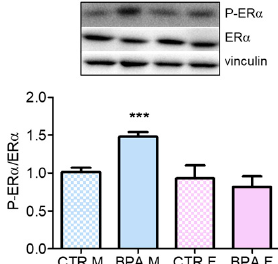
Figure 8. ER α phosphorylation state in the brain of rat fetuses in utero exposed to 2.5 µ g / kg / day of BPA. Representative western blot of P-ER α and total ER α . The graph represents the densitometric analysis of the ratio between phosphorylated and total form. Data are expressed as means ± SD. Vinculin served as housekeeping protein to normalize protein loading. Statistical analysis was carried out by using two-way ANOVA followed by Bonferroni post-hoc test. *** = p < 0.001 vs. CTR M.